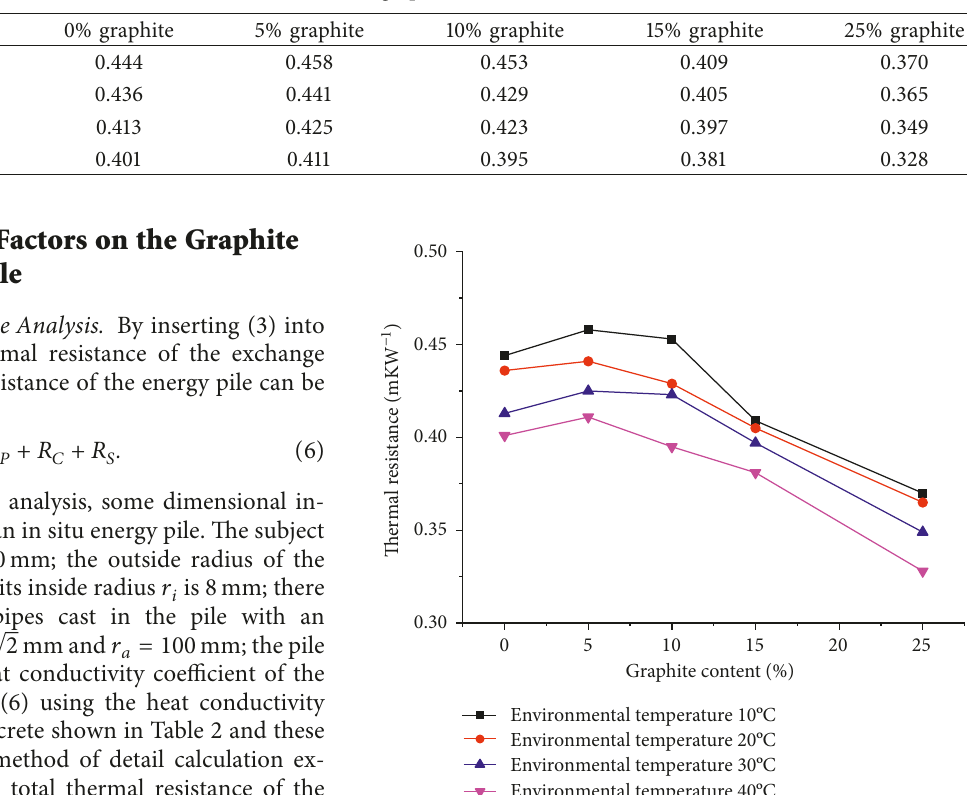
Table 3: Total thermal resistance for different graphite volumetric contents (mKW